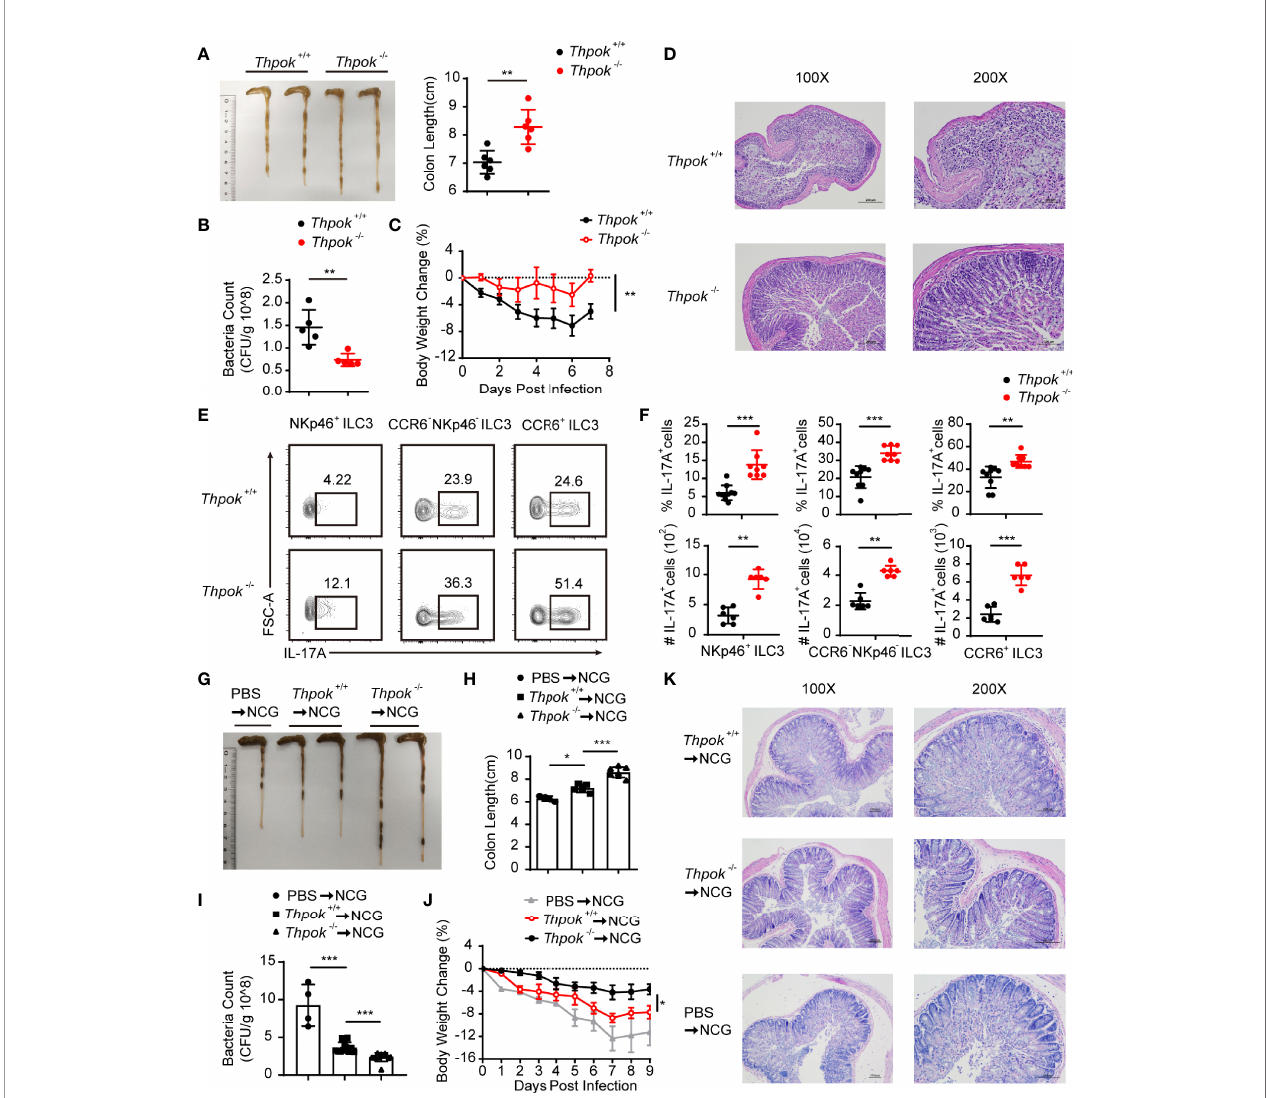
FIGURE 4 | Decreased sensitivity to C. rodentium infection with IL-17A upregulation after ThPOK deletion. (A – F) ThPOK-de fi cient mice and their WT littermates were orally inoculated with 5 × 10 9 CFUs of C . rodentium after treated with ABX for 1 week. Body weight were monitored for 7 days, and all mice were sacri fi ced at day 7. (A) Colons from ThPOK-de fi cient mice and their WT littermates were shown after infection at day 7 (left). Statistical analysis of the colon length (right). (mean ± SEM; n = 6; * P < 0.05, Student ’ s t test). (B) C . rodentium CFU in the feces on day 9 (mean ± SEM; n = 5; * P < 0.05, Student ’ s t test). (C) Body weight changes were monitored at the indicated time points. (mean ± SEM; n = 9; ** P < 0.01, Student ’ s t test). (D) H&E staining of colon tissue sections was determined 7 days after infection. (E, F) Representative fl ow plots and quanti fi cation of IL-17A production from NKp46 + ILC3s (left), CCR6 - NKp46 - ILC3s (middle), and CCR6 + ILC3s (right) isolated from the siLP at day 7 after infection. (mean ± SEM; n = 6-9; ** P < 0.01, *** P < 0.001, Student ’ s t test). (G – K) NCG mice were adoptively transferred with 80000 intestinal ILC3s sorted from ThPOK-de fi cient and WT mice or PBS as control after treated with ABX for 1 week. ILC3s were stimulated with IL-23 and IL-1 b , at the concentration of 40 ng/ml, for 30min before injected to NCG mice through the tail vein. NCG mice were orally inoculated with C . rodentium 24 hours post adoptive transfer. Body weight were monitored for 9 days, and all mice were sacri fi ced at day 9. (G, H) Colon length for NCG recipients were measured and shown after C . rodentium infection at day 9. (mean ± SEM; n = 4-7; * P < 0.05, *** P < 0.001, Student ’ s t test). (I) Bacterial counts in the feces at day 9 after infection. (mean ± SEM; n = 4-11; *** P < 0.001, Student ’ s t test). (J) Body weight changes at the indicated time points. (mean ± SEM; n = 6-11; * P < 0.05, Student ’ s t test). (K) H&E staining of colon tissue sections was determined 9 days after infection. Data are representative of at least three independent